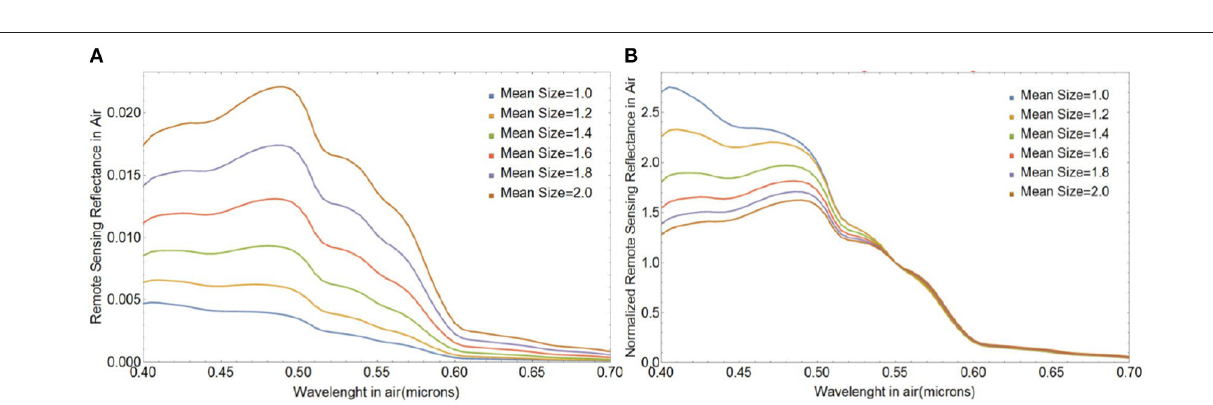
FIGURE 10 | (A) Absolute and (B) normalized spectral remote sensing reflectance R rs ( λ ) (in sr − 1 ) for populations of free coccoliths of varying mean size, a 0 . The standard deviation of the size distribution was 0.15 µ